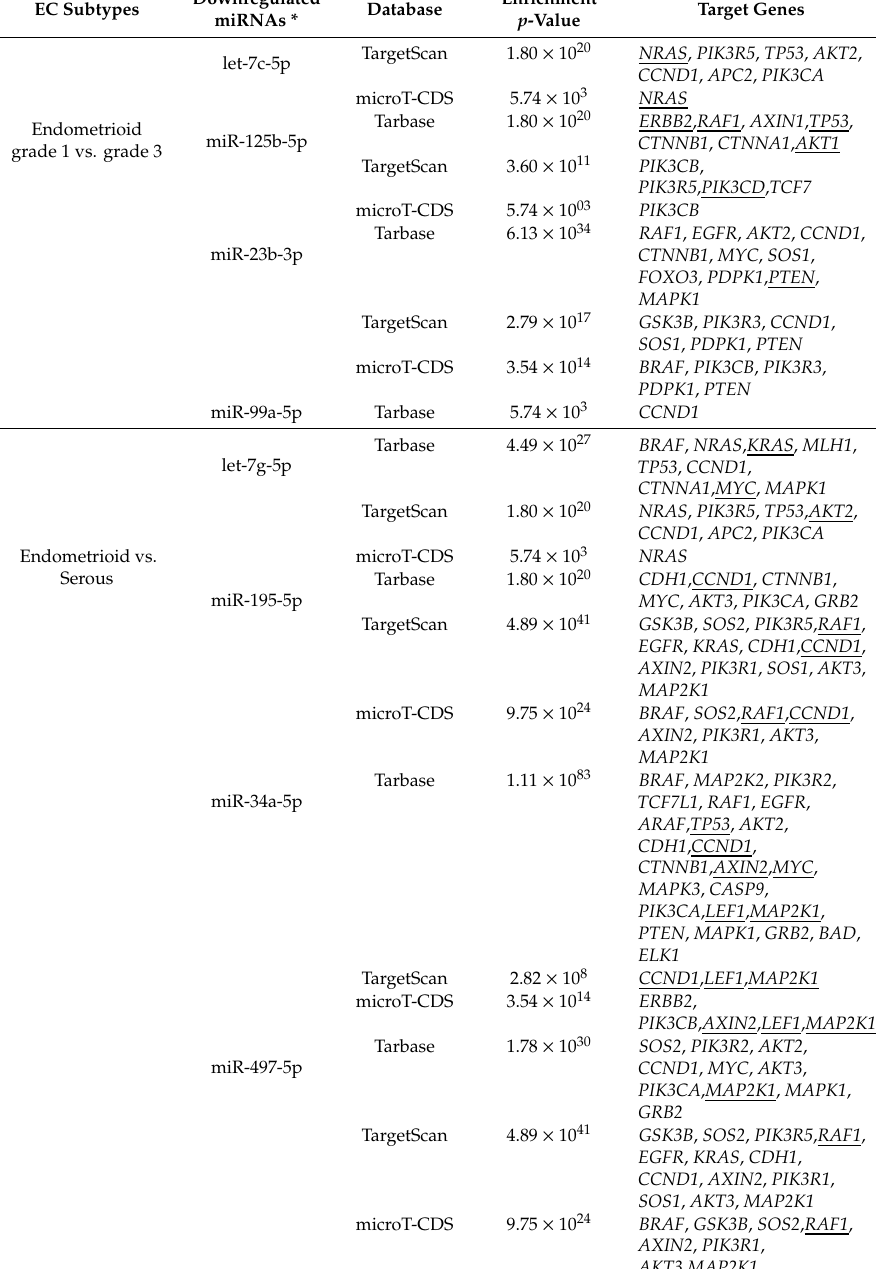
Table2. TargetgenesofsignificantlydownregulatedmiRNAsinmoreadvancedsubtypesofendometrial carcinoma identified by bioinformatic